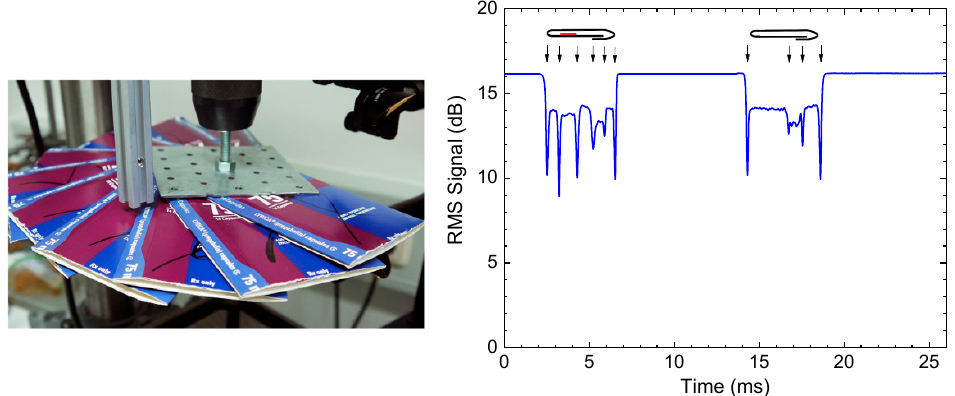
Figure 27. ( a ) Boxes arranged on a fast turntable. ( b ) 1D-scan of folded cardboard boxes with and without a package slip (shown in red). The graph depicts the transmitted THz intensity with the boxes moving at 21 m/s. Adapted from [195].